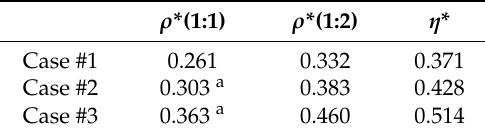
Table 1. Systems investigated in this